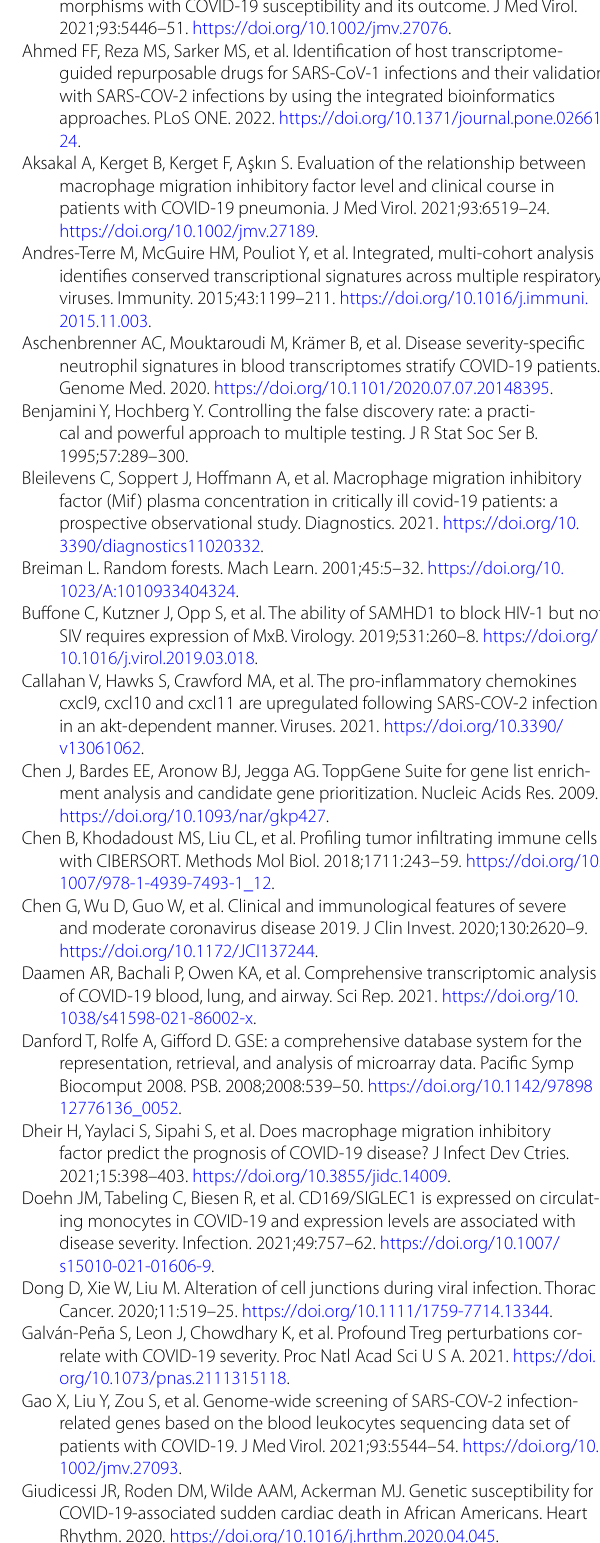
and ToppGene databases; The common results of GO-terms and enriched pathways between EnrichR and ToppGene databases when nasopharyn- geal transcriptome of COVID-19 compared with that of healthy controls/ non-viral acute respiratory illnesses (ARIs)/other viral ARIs. Additional file 5: Table S4. Common differentially expressed genes between SARS-COV-2 infected whole blood and nasopharyngeal samples when compared with healthy controls; Significant biological processes (BPs) molecular functions (MFs), and cellular components (CCs) categories obtained from EnrichR and ToppGene databases; Significant hallmark pathways and enriched pathways acquired by EnrichR and ToppGene data- bases; The common results of GO-terms and enriched pathways between EnrichR and ToppGene databases. Additional file 6: Table S5. The statistical criteria for the best combina- tions of the features obtained from the LASSO method in the first and second phases based on Random Forest (RF) classification among whole blood and nasopharyngeal data. Additional file 7: Table S6. The significant GO terms and enriched path- ways for LASSO features of WB and NP samples. Additional file 8: Table S7. The statistical criteria for top 100 panels (3 to 9-diagnostic markers) obtained from the common WB/NP DEGs based on the train and test sets in WB and NP